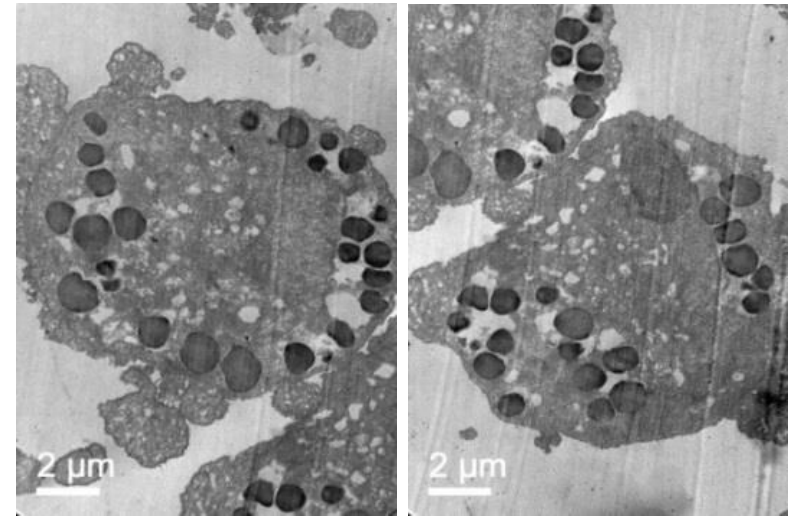
Figure 12. TEM images of pathological fibroblasts incubated with elosulfase alfa-NLC for 3 h.